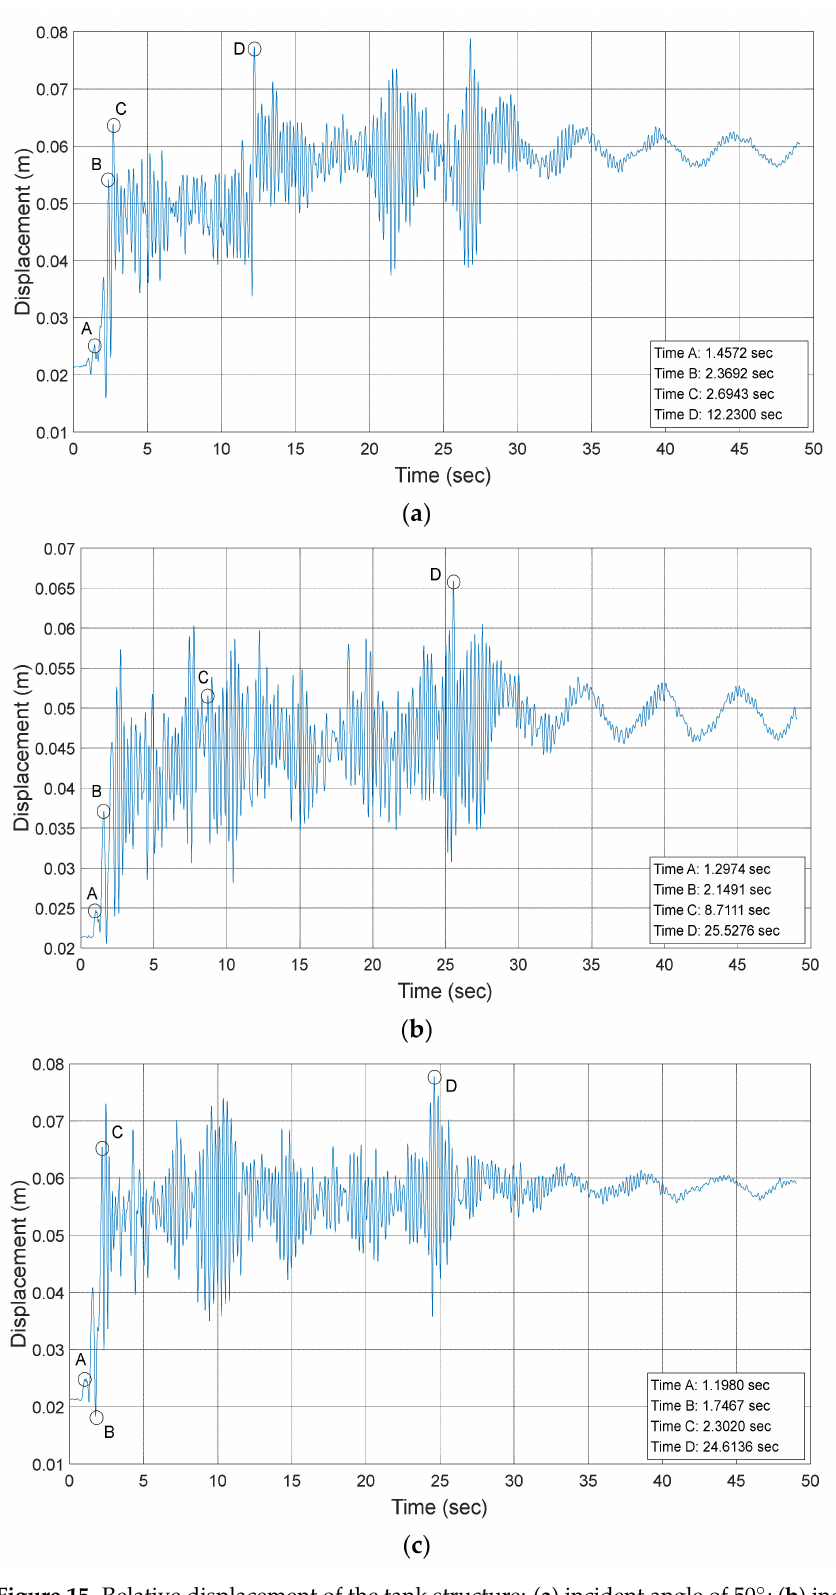
Figure 15. Relative displacement of the tank structure: ( a ) incident angle of 50 ◦ ; ( b ) incident angle of 100 ◦ ; ( c ) incident angle of 140 ◦